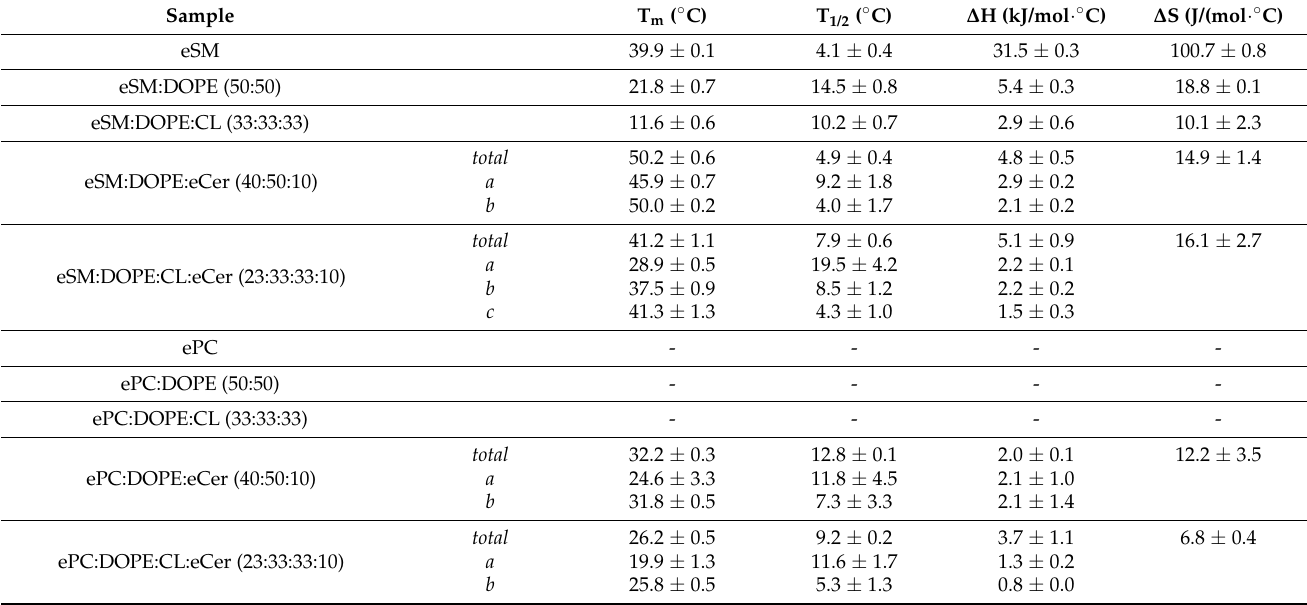
Table 1. Thermodynamic parameters of the gel–fluid transitions, as obtained from DSC experiments. Average values ± SD (n = 3). a, b , and c refer to the various components of the total endotherm when it was decomposed for its proper